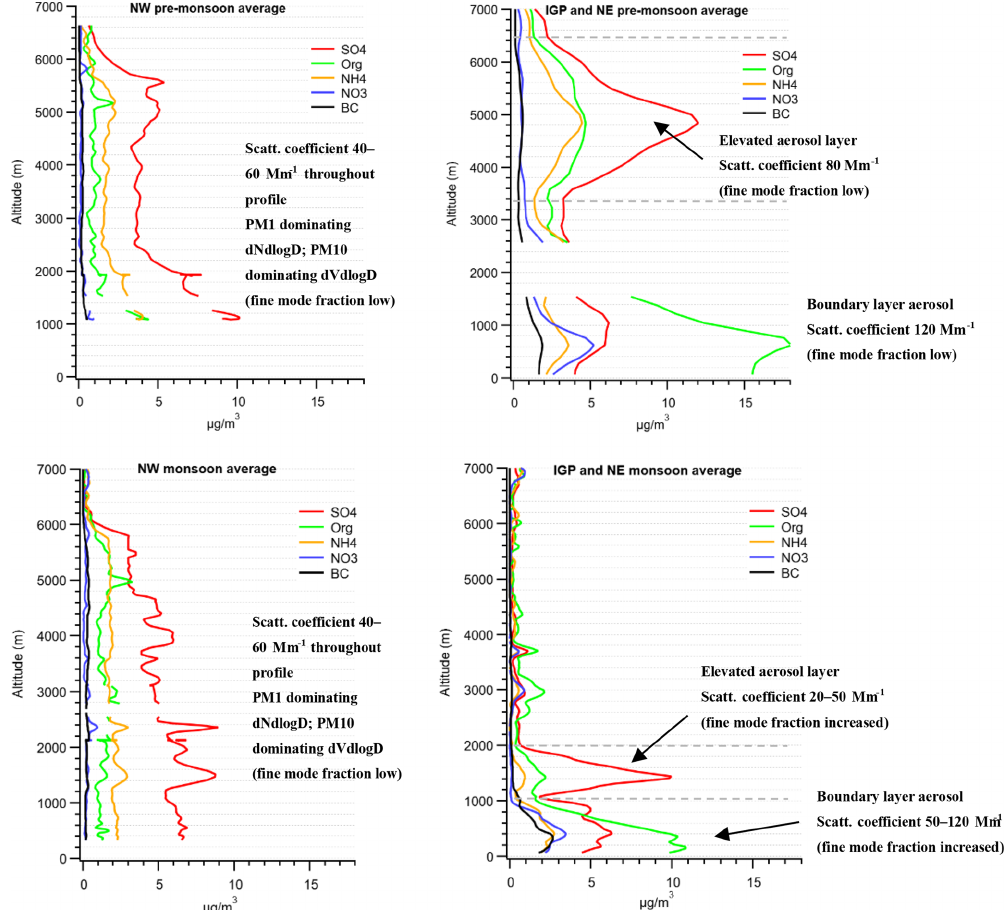
Figure 5. Aerosol vertical profile summary for pre-monsoon and monsoon seasons during the campaign, for NW India and the IGP/NE